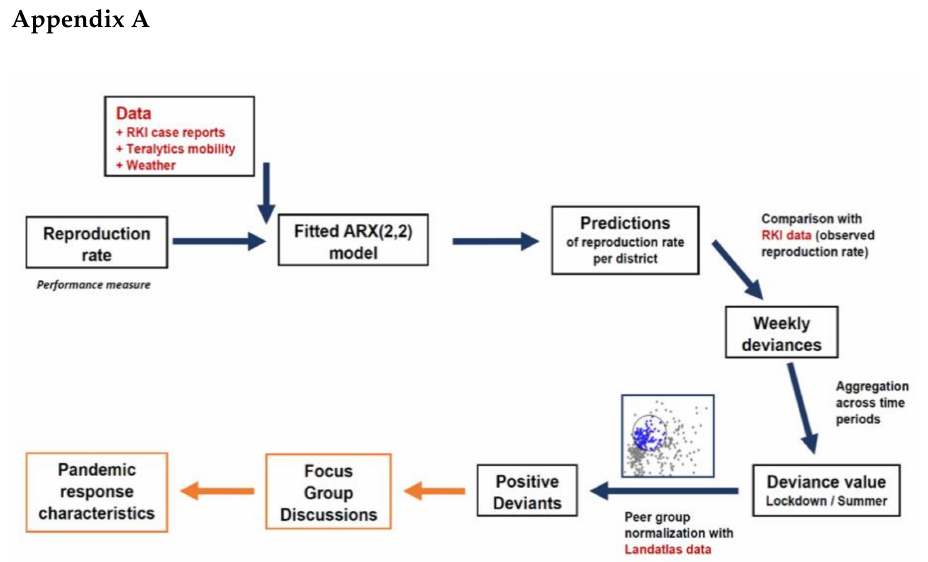
Figure A1. Procedural flowchart of analysis. RKI—Robert Koch Institute, ARX—auto-regressive model with exogenous input.